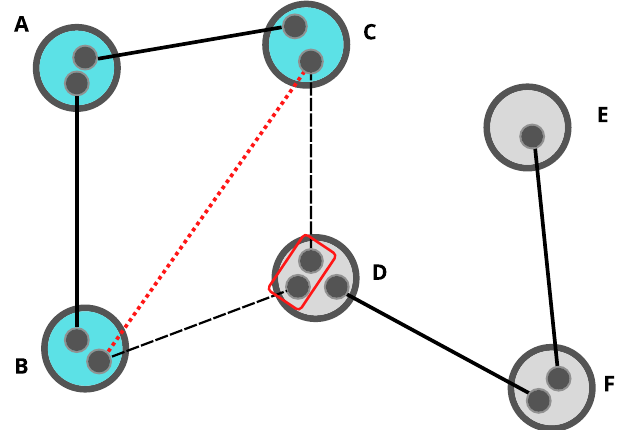
Fig. 1 Schematic representation of a quantum network. The larger circles represent nodes. The smaller, enclosed circles represent entangled qubits. Each link in the network represents a pair of entangled qubits shared between the two connected nodes. The original network is represented by the black solid and dashed lines. Node D performs a local measurement (represented by the red rectangle) on the qubits it shares with nodes B and C, causing the qubits in B and C to become entangled, represented by the dotted red line. The previous entanglement, represented by the dashed black line, is lost. Entanglement swapping can modify the topology of a quantum network, changing its percolation threshold. In this example, a fully connected network is split into two disjoint components, consisting of nodes A – C (in turqoise) and nodes D – F (in